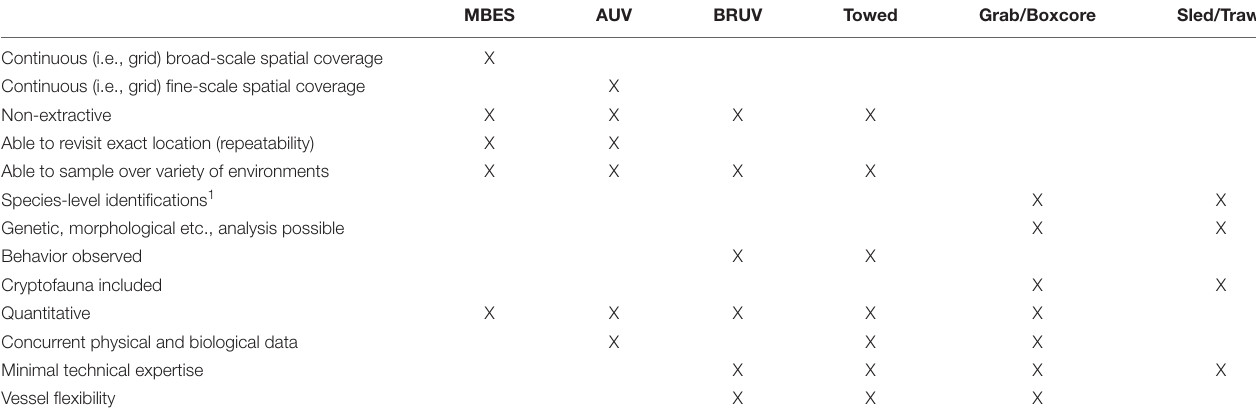
TABLE 2 | Advantages of prioritized benthic sampling platforms, from Przeslawski and Foster (2018). MBES AUV